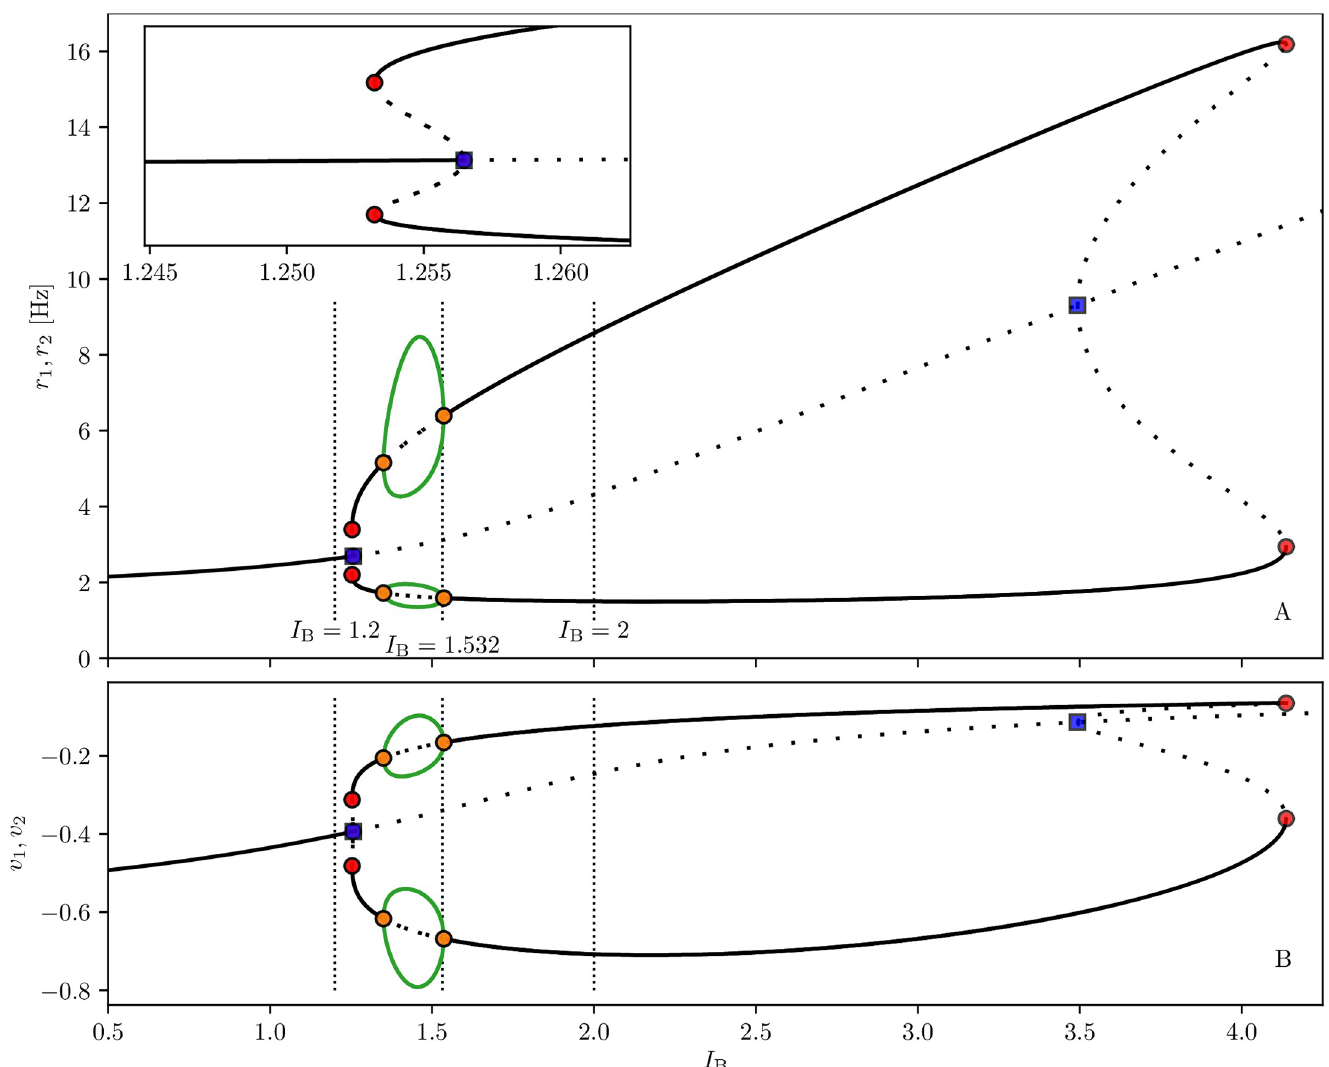
Fig 13. Bifurcation diagram for two excitatory populations. Bifurcation diagram displaying the instantaneous firing rates r k (A) and mean membrane potentials v k (B) for the excitatory populations as a function of the background current I B . Solid (dashed) black lines refer to stable (unstable) asynchronous states, while green solid lines denote the maxima and the minima of stable collective oscillations. Symbol refer to bifurcation points: branch points (blue squares), Hopf bifurcations (orange circles) and saddle-node bifurcations (red circles). The inset in (A) displays an enlargement of the bifurcation diagram. The lower (upper) branch of equilibria in (A) corresponds to the lower (upper) branch in (B). All the remaining parameters are as in Fig 3. Continuation performed with the software AUTO-07P